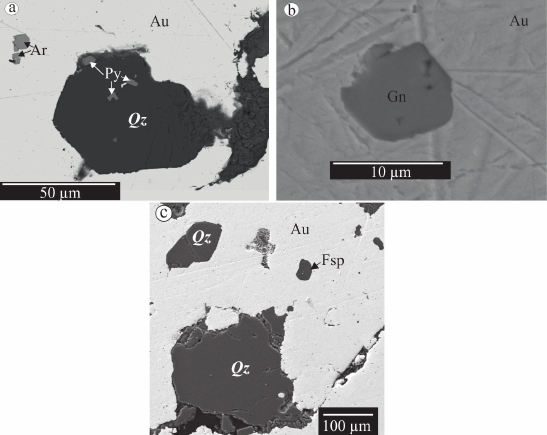
Figure 9. Mineral inclusions in placer gold of the Mayat river (BSE mode): ( a ) quartz (Qz), pyrite (Py) and arsenopyrite (Ar) inclusions in native gold (Au); ( b ) galena inclusion (Gn) in native gold (Au); ( c ) quartz (Qz) and potassium feldspar inclusions (Fsp) in native gold (Au), shot in BSE mode.